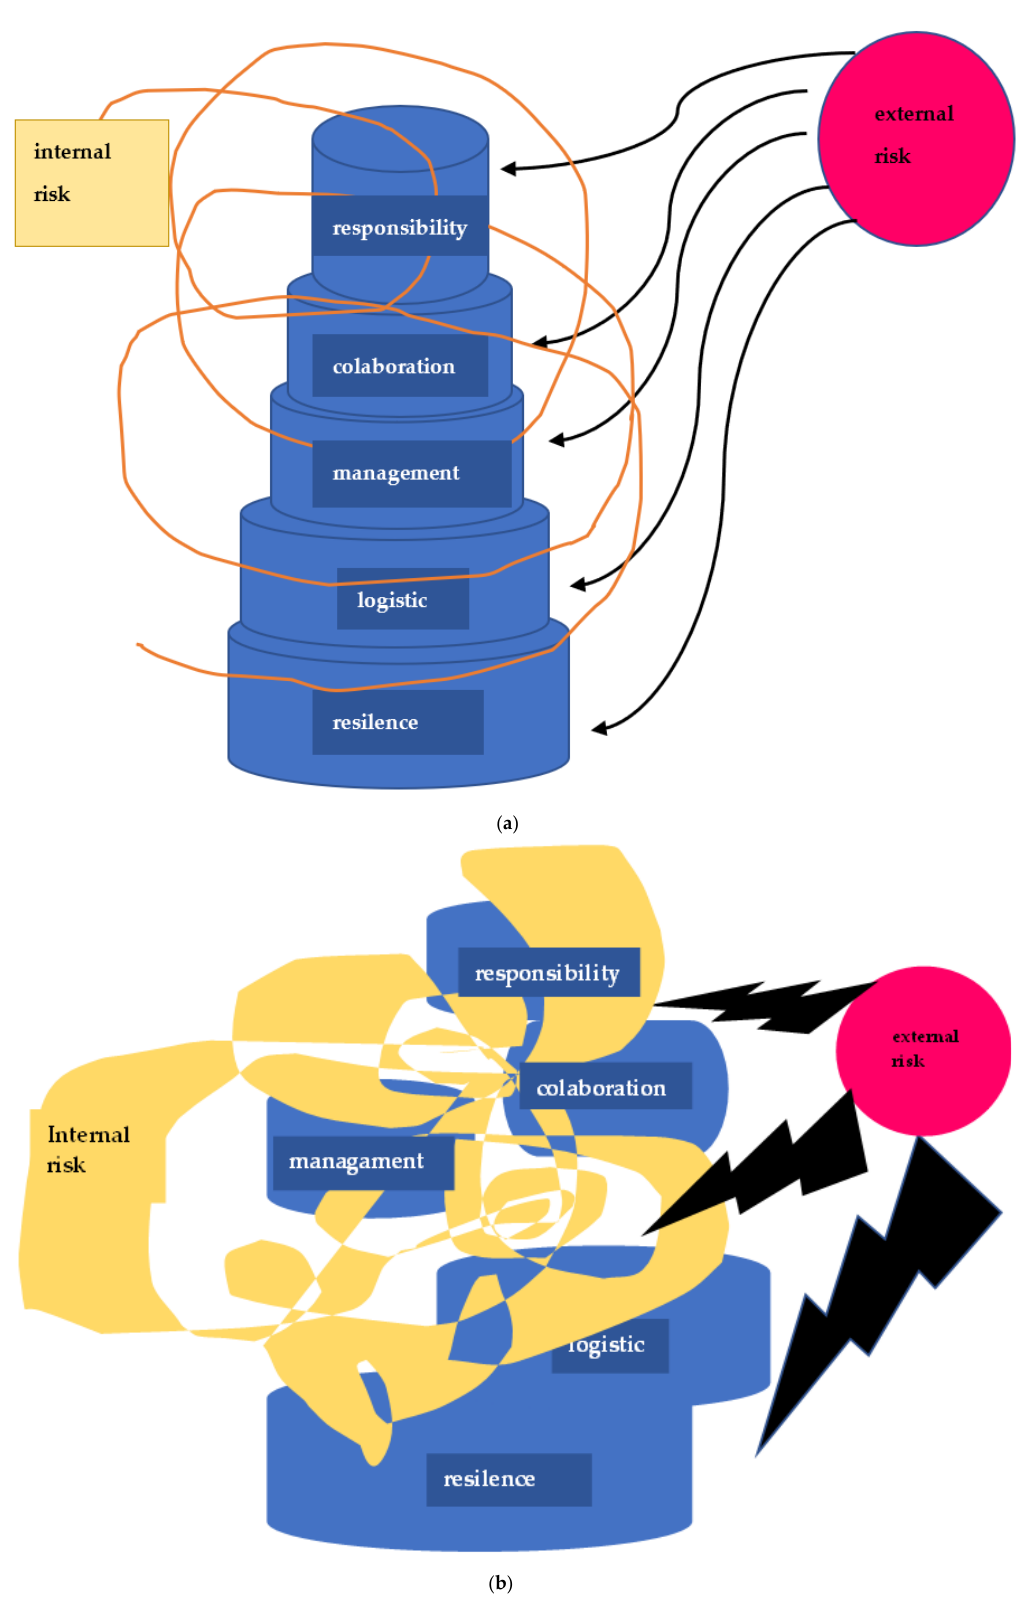
Figure 2. ( a ) A diagram of the balanced behavior of the main attributes of the supply chain as part of risk monitoring. Source: (own performance). ( b ) An unbalanced supply chain arrangement resulting from the turmoil that arose due to the lack of risk monitoring. Source: (own performance). Table 5. Assessment of the possibility of key risks in supply chains.